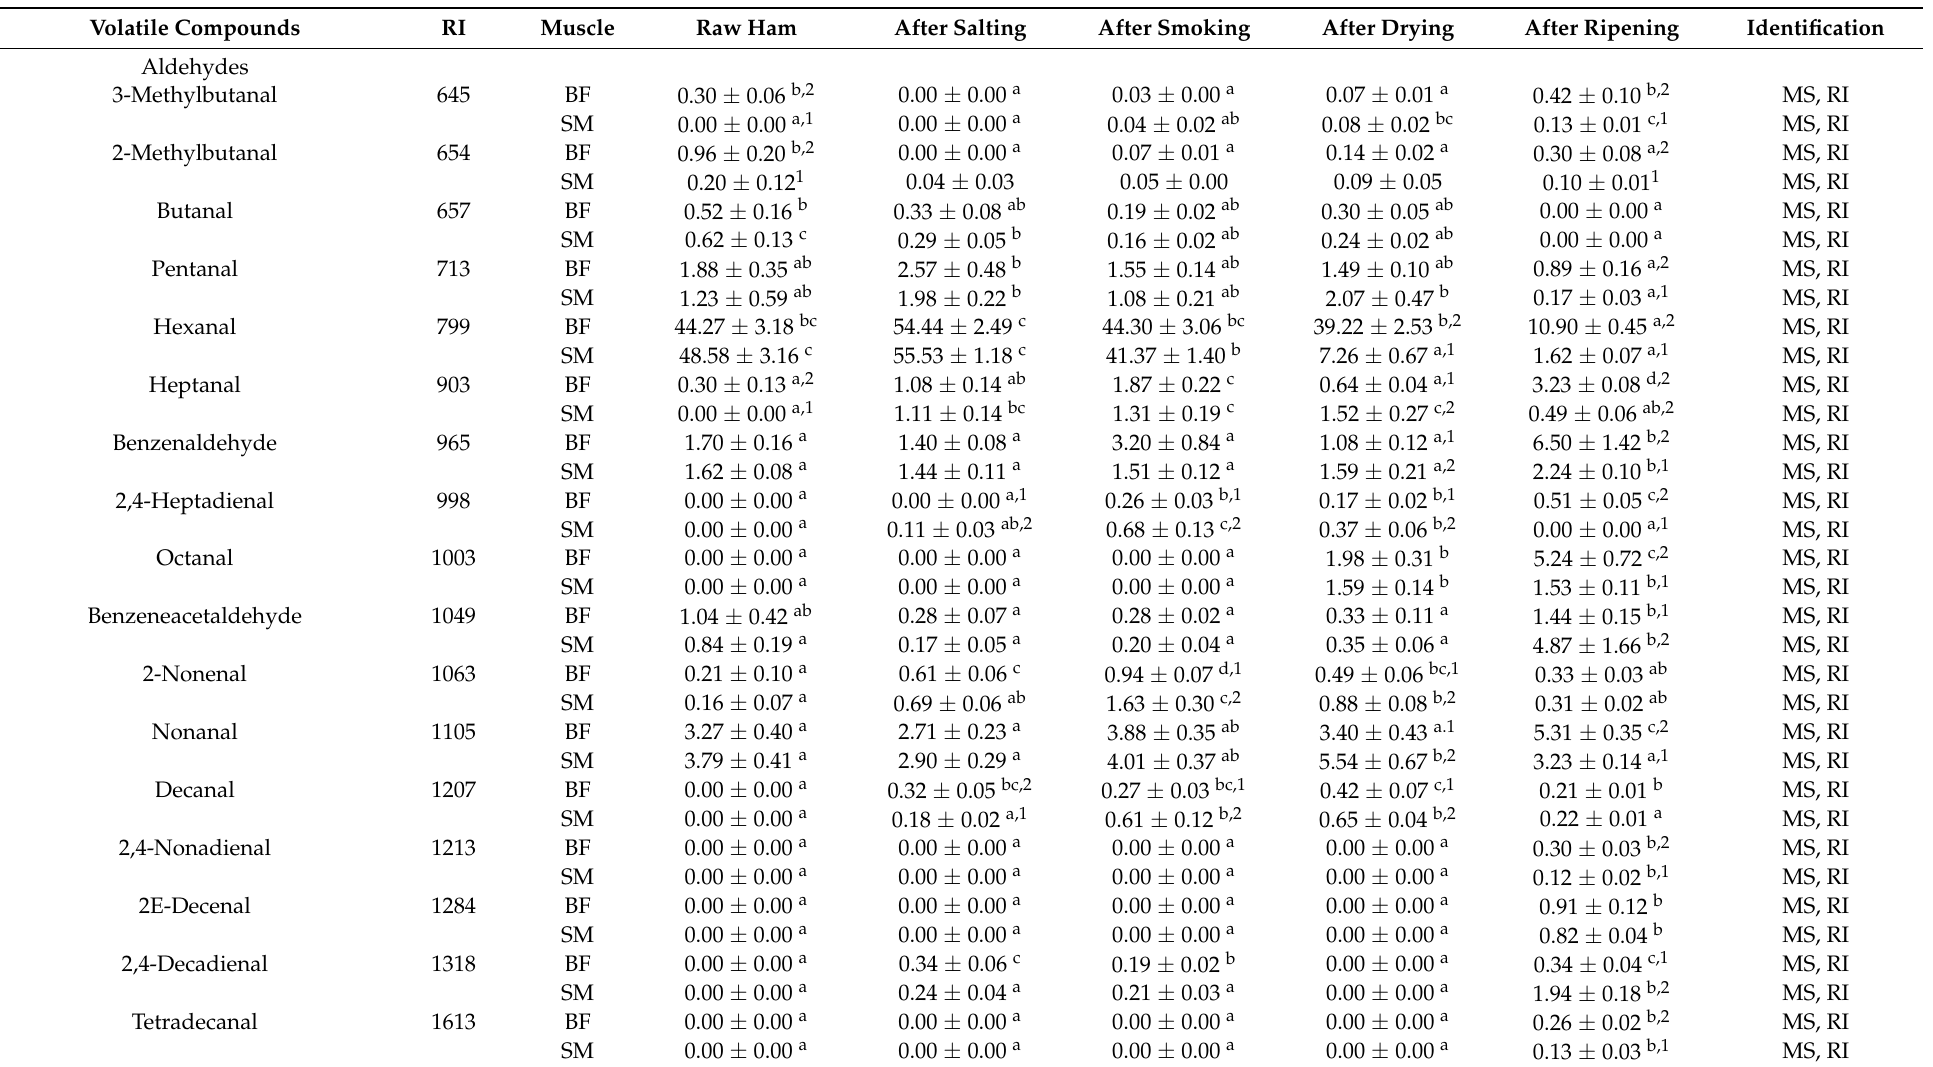
Table 5. Evolution of volatile compounds (percentage of the total area) through the manufacturing of smoked dry-cured ham (results expressed as mean ± standard error). Volatile Compounds RI Muscle Raw Ham After Salting After Smoking After Drying After Ripening Identification